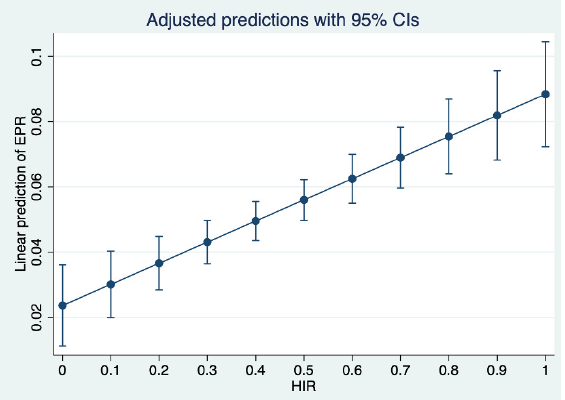
Figure 3. Adjusted prediction of early edema progression by HIR. A multivariable logistic regres- sion plot was used to demonstrate the linear prediction of early edema progression rate (EPR, y axis) based on the hypoperfusion intensity ratio (HIR, x axis). EPR = Early Edema Progression Rate; HIR = Hypoperfusion Intensity Ratio; 95% CI = 95% Confidence Interval.